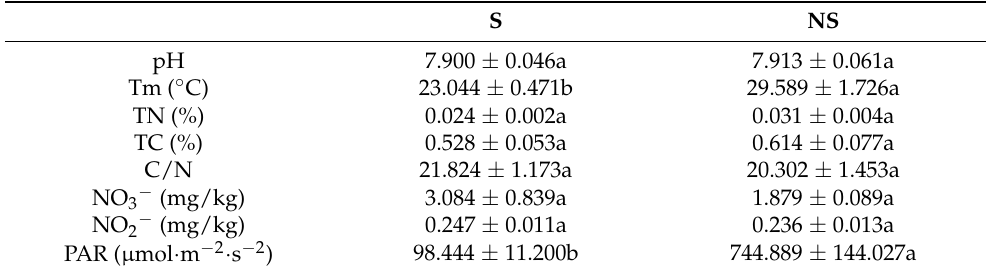
Table 1. Physicochemical properties in shading and non-shading soil in this